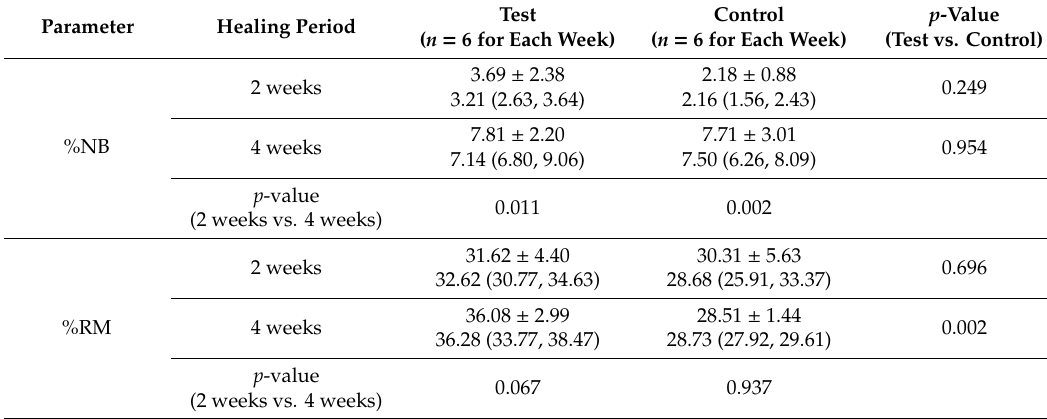
Table A1. Percentage of newly formed bone and residual bone substitute material in the total augmented area.